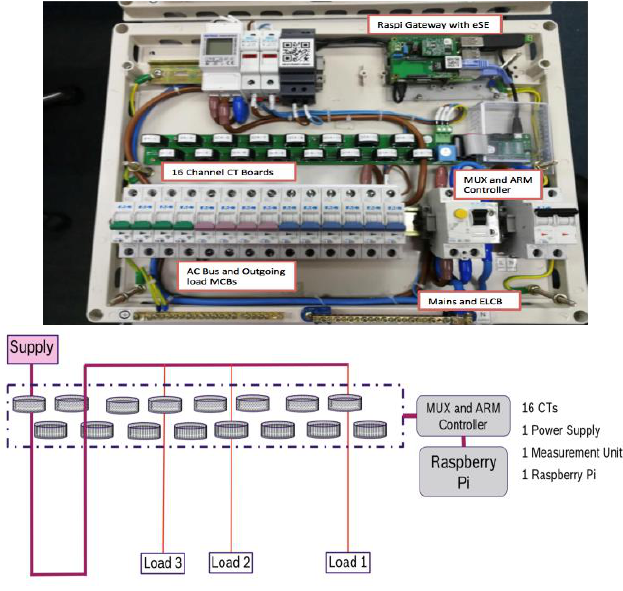
Figure 5. Smart DB layout and Schematic of 16 CT sensor boards.